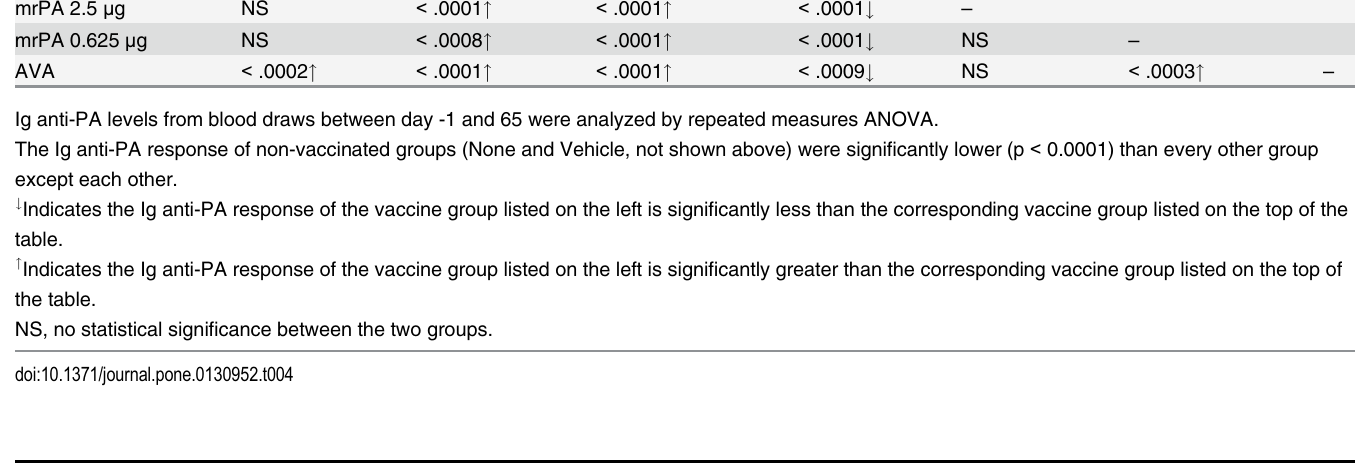
table. " Indicates the Ig anti-PA response of the vaccine group listed on the left is signi fi cantly greater than the corresponding vaccine group listed on the top of the table. NS, no statistical signi fi cance between the two